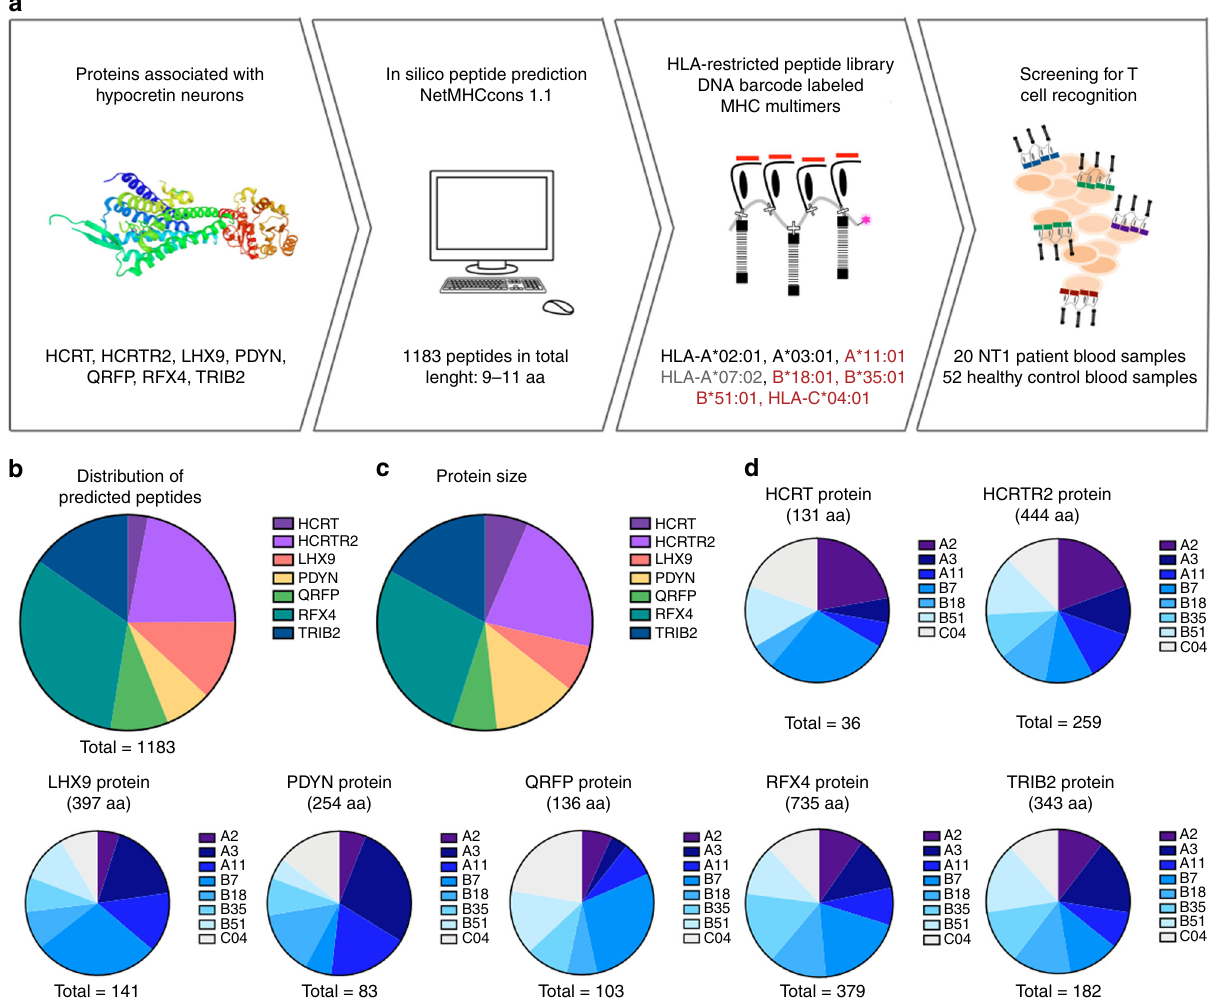
Fig. 1 Experiment strategy and peptide prediction. a From seven different proteins, peptides with strong binding af fi nity to eight different HLA types were predicted using the prediction server NetMHCcons1.1. NT1-associated, protective and neutral HLA types are indicated in red, gray and black, respectively. The predicted peptides were used to generate 1183 unique pMHC multimers labeled with DNA barcodes, that were in turn used to screen NT1 patients and healthy controls. b All predicted peptides distributed according to protein of origin. c The comparative size of the different proteins included. d The distribution of the predicted peptides among the eight chosen HLA types within each protein. aa: amino acid. HCRTR2: hypocretin receptor 2. LHX9: